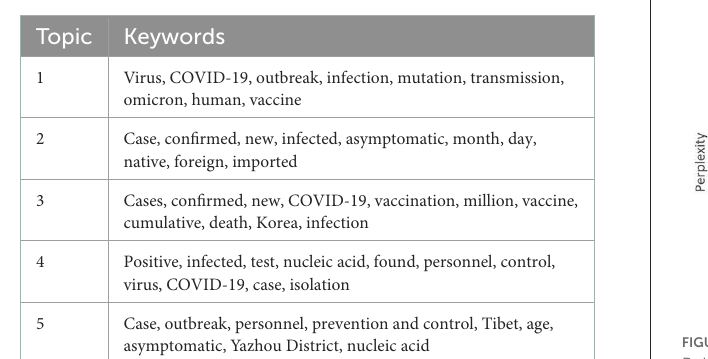
TABLE 5 Keywords of the five topics with emotion of fear.